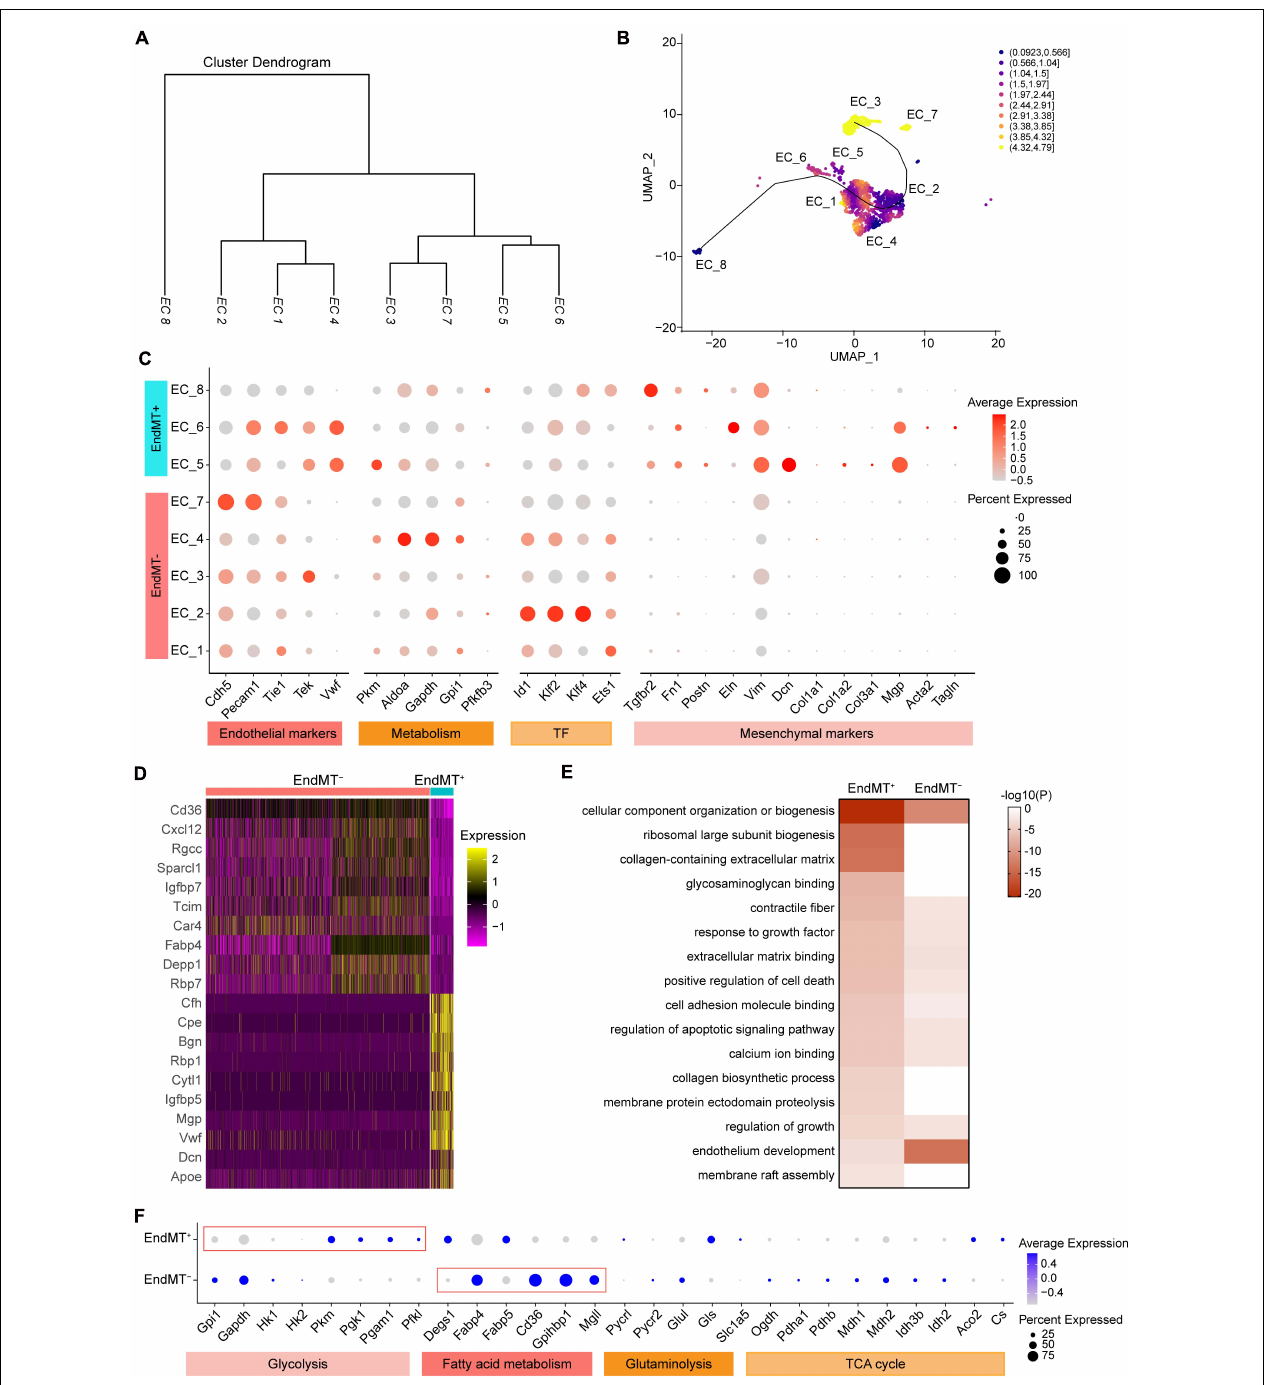
FIGURE 5 | Identification of endothelial cell subpopulations undergoing mesenchymal transition. (A) , Dendrogram summarizing the similarity of the EC clusters in the aggregate arterial ECs according to average RNA expression. (B) , Two-dimensional representation of EC clusters using UMAP, with trajectory inferred by the interpretation of Slingshot and tradeSeq analysis. Color indicates imbalance score. Regions with a high score indicate that the local cell distribution is unbalanced compared to the overall distribution. (C) , Dot plot showing the marker genes associated with EC identity, metabolism, transcription factor, and mesenchymal identity in EndMT − (EC marker positive and mesenchymal marker negative) and EndMT + (EC marker positive and mesenchymal marker positive). Size depicts the percentage of cell expressing each gene, and color indicates the expression level. (D) , Heatmap showing the top10 genes selected from all markers of EndMT − and EndMT + cells based on the average Log2(fold change). (E) , Heatmap showing the representative GO-terms enrichment of the specific genes in EndMT + cells in comparison to EndMT − cells. The color indicates the -log 10 (P) value. (F) , Dot plot showing the expression of genes associated with glycolysis, fatty acid metabolism, glutaminolysis, and tricarboxylic acid (TCA) cycle comparing EndMT − and EndMT + cells.